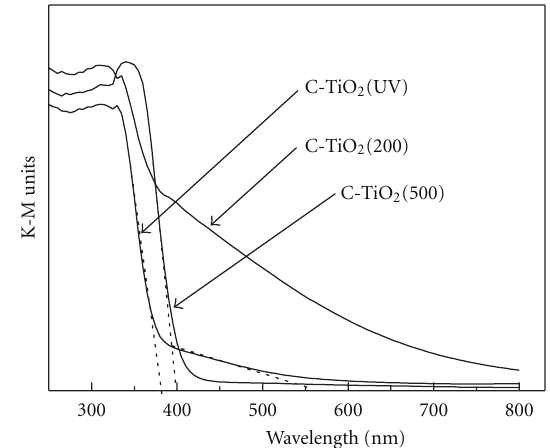
Figure 6: The EPR spectra of C-TiO 2 (UV) and C-TiO 2 (200) measured at room temperature.